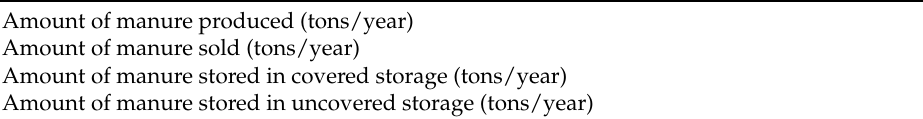
Table 4. The input data requirements of manure storage.